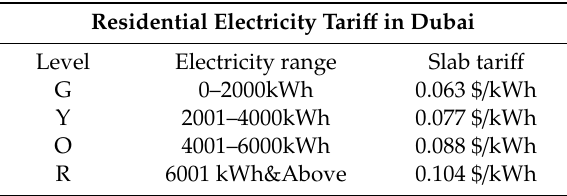
Table 2. Residential electricity tari ff in